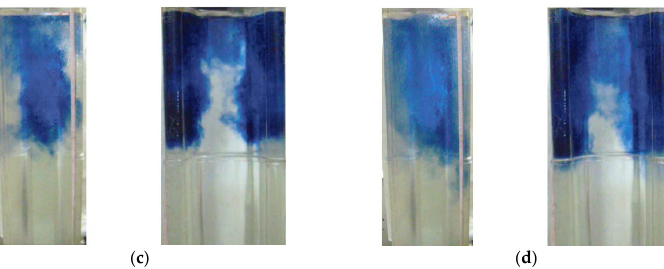
Figure 5. Flow pattern in mold in narrow face view ( left ) and wide face view ( right ): ( a ) 0 s, ( b ) 0.6 s, ( c ) 1.2 s, ( d ) 3.4 s. On the other hand, the velocity vector diagram was obtained from mathematical modeling, as shown in Figure 6. These pictures provide more information on the flow in the perturbed zone of Figure 5. There are two pairs of vortices in both the web region and flange region. In the web, there are two big vortices below the funnel’s bottom and two small vortices in the area between the funnel’s bottom and the slag/steel interface. In the flange region, a pair of big vortices appears on each side of the funnel. Two small vortices are on top of each big vortex, and their trajectories are less clear than those in the web. This could be the cause of the more regular shape, like a slab, which is helpful for obtaining well-ordered flow trajectories. Furthermore, the centers of the small vortices in the flange region are closer to the slag/steel interface than those in the web region.